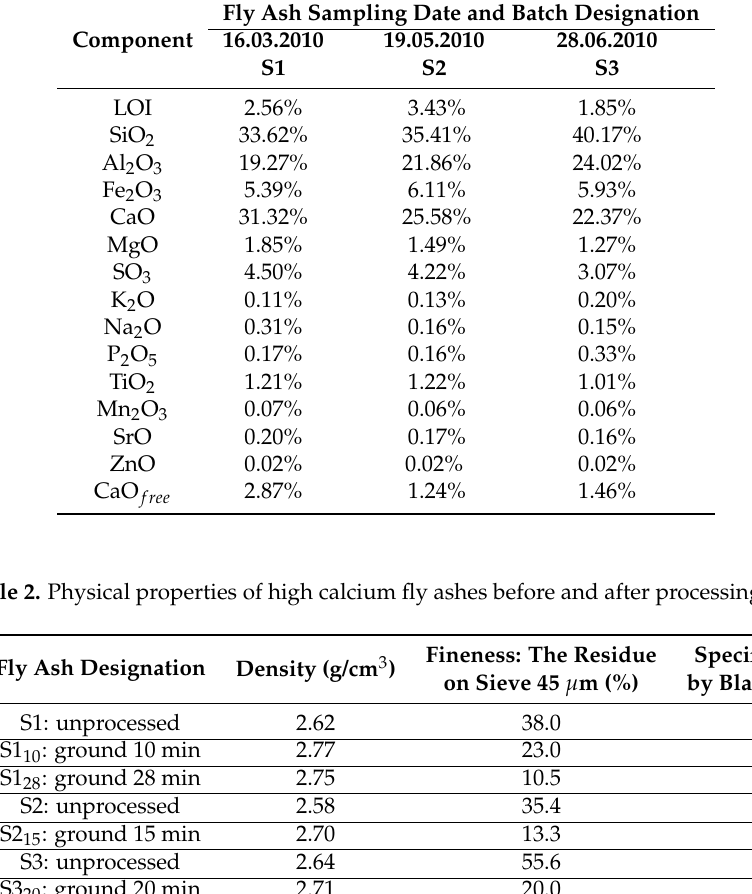
Table 1. The chemical composition of high calcium fly ashes from Bełchatów power plant in Poland, determined using the XRF (X-ray fluorescence) method. Fly ash sampling date and bath designation [19].